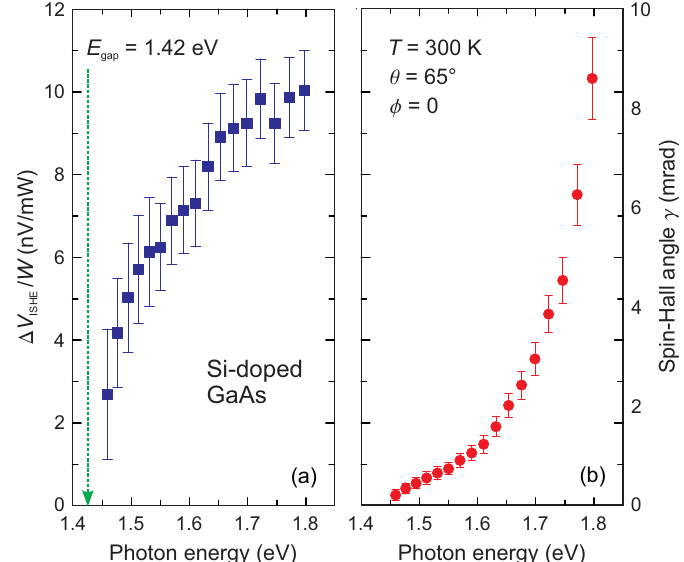
Figure 3. ( a ) Room temperature ISHE signal in Si-doped GaAs as a function of the incident photon energy in the 1.42-1.8 eV range for θ = 65 ◦ and φ = 0. The values are normalized with respect to the power W entering into the GaAs sample (evaluated with a GaAs reflectivity equal to 0.34); ( b ) Room temperature spin-Hall angle γ , extrapolated from panel